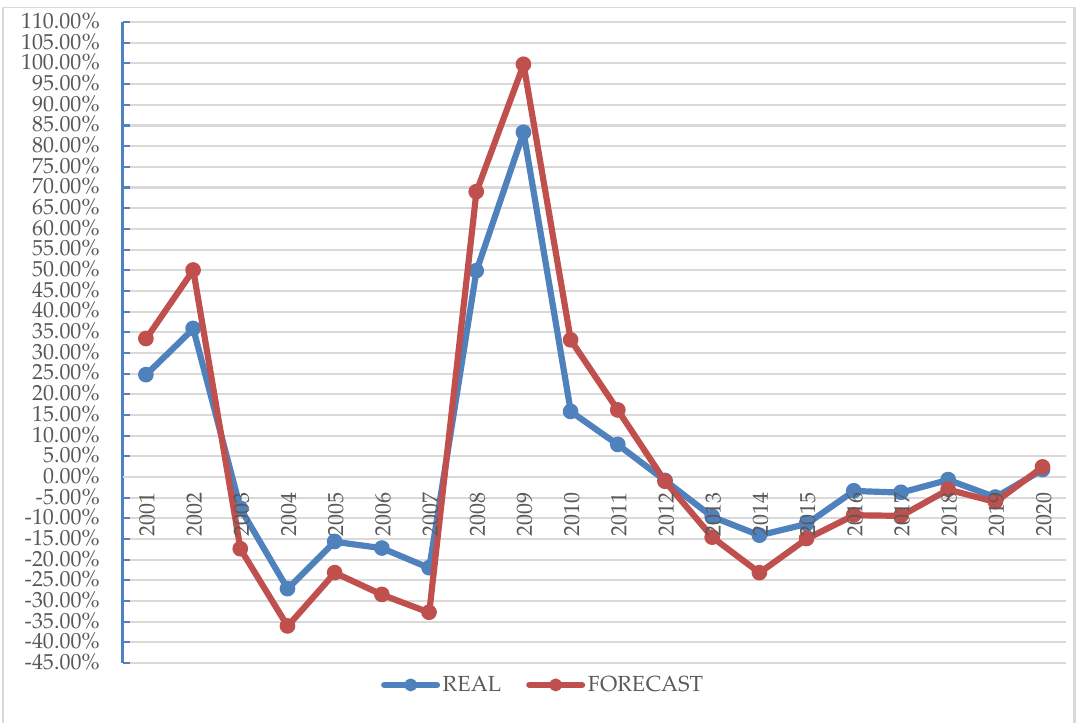
Figure 6. Yearly fluctuations in the volume of nonperforming loans in Poland (real versus forecasted). Source: based on the author’s own calculations.